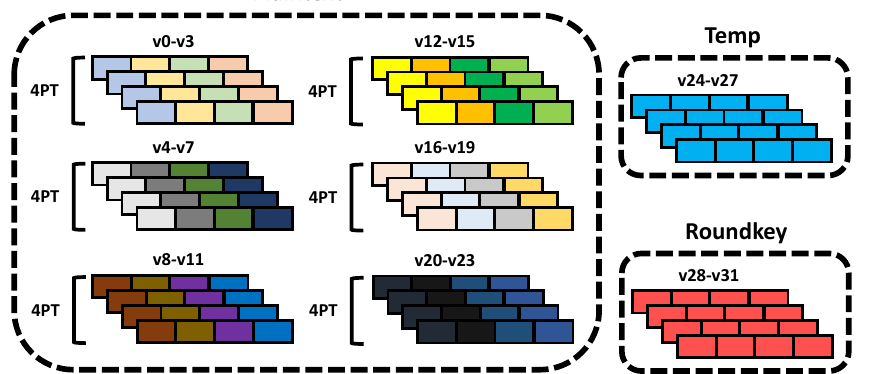
Figure 8. Proposed vector register scheduling for